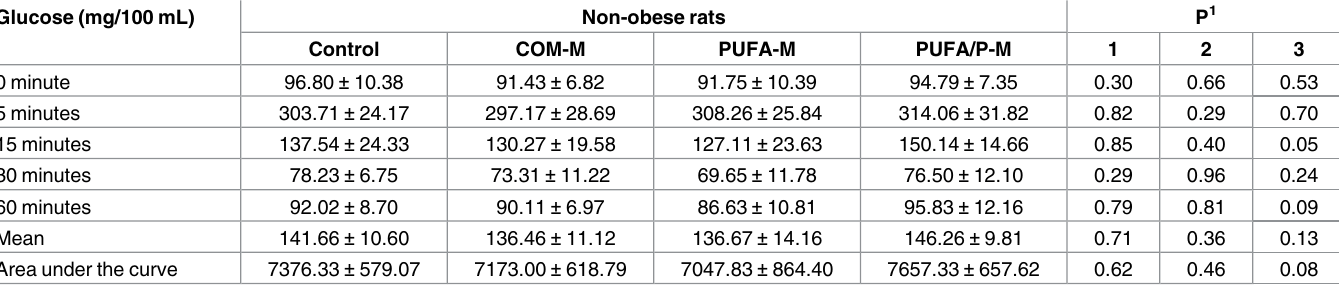
Table 4. Blood concentrations of glucose during glucose tolerance test in non-obese rats fed a diet supplemented with common milk (COM-M), milk enriched with polyunsaturated fatty acids (PUFA-M) or milk enriched with PUFA and polyphenols (PUFA/P-M). Glucose (mg/100